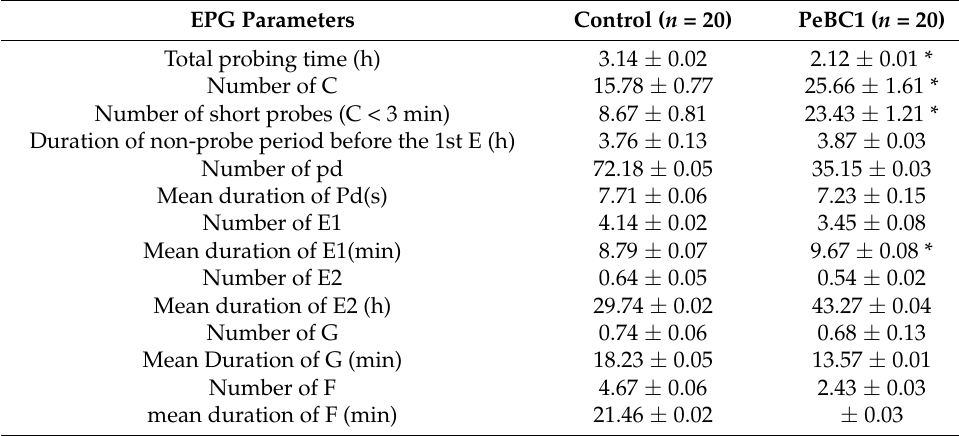
Table 4. M. persicae electrical penetration graph (EPG) data on PeBC1-treated and untreated chilli plants. Mean ± SD. Pathway activities are represented by C, potential drop is represented by Pd, phloem-feeding E represents activities, F represents penetration difficulty, G represents xylem-feeding activities, saliva injection is represented by E1, and sap sucking is represented by E2. Data were compared statistically using an independent t -test with two tails in SPSS 18.0. The difference between PeBC1 and control treatment with the same parameters of * ( p = 0.05) is shown by asterisks. EPG Parameters Control ( n = 20) PeBC1 ( n = 20) Total probing time